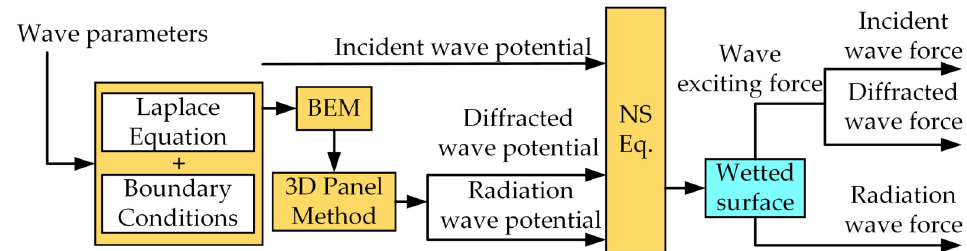
Figure 5. The numerical computation progress of wave